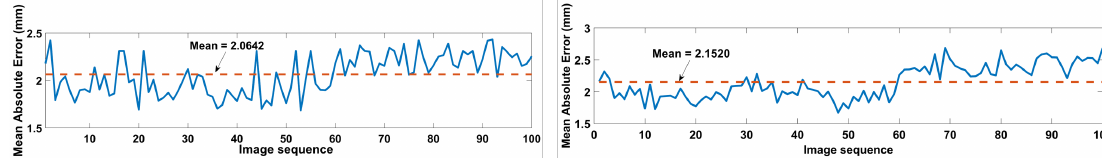
Figure 11. Mean of absolute errors in 100 frames for ( Left ) 2.45 N load. ( Right ) 14.71 N